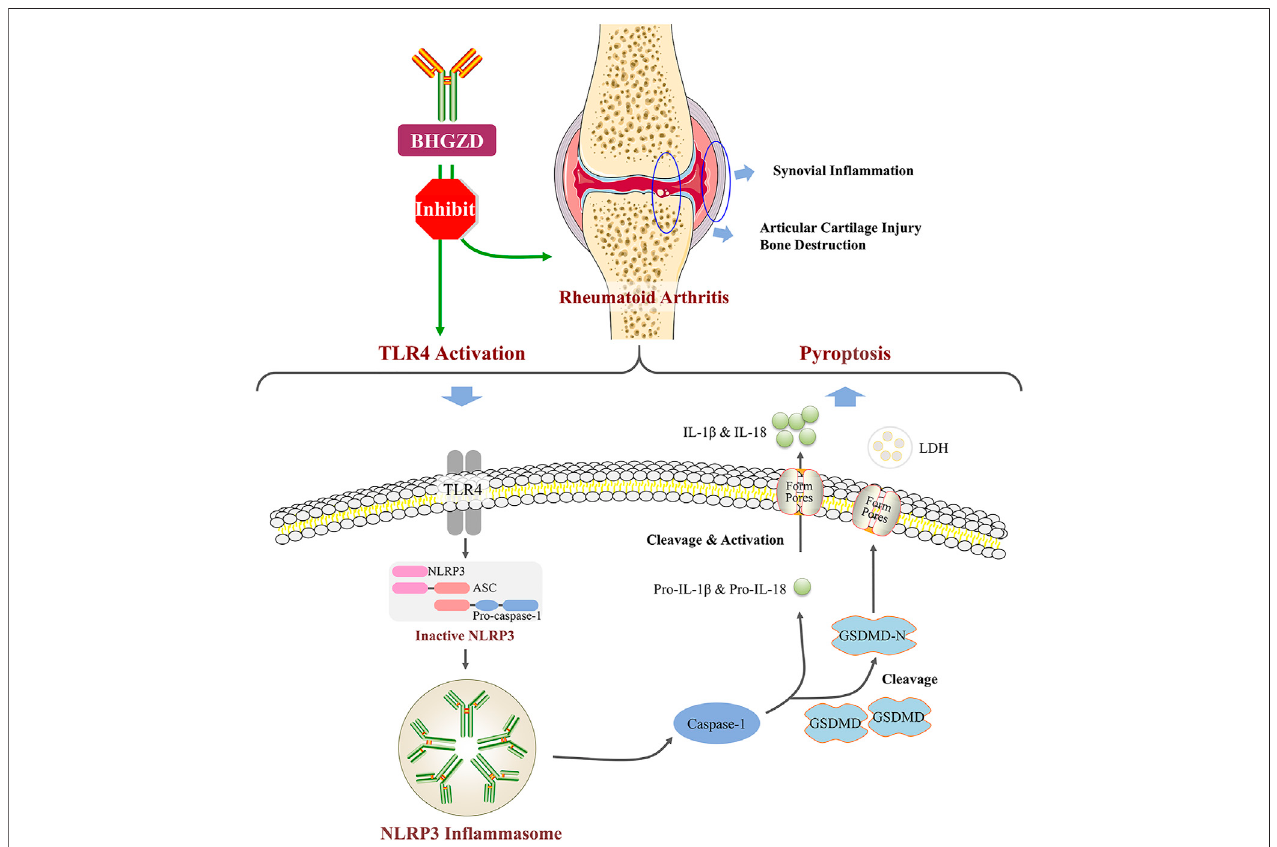
FIGURE 6 | BHGZD attenuates RA via suppressing TLR4 – mediated NLRP3 in fl ammasome activation.